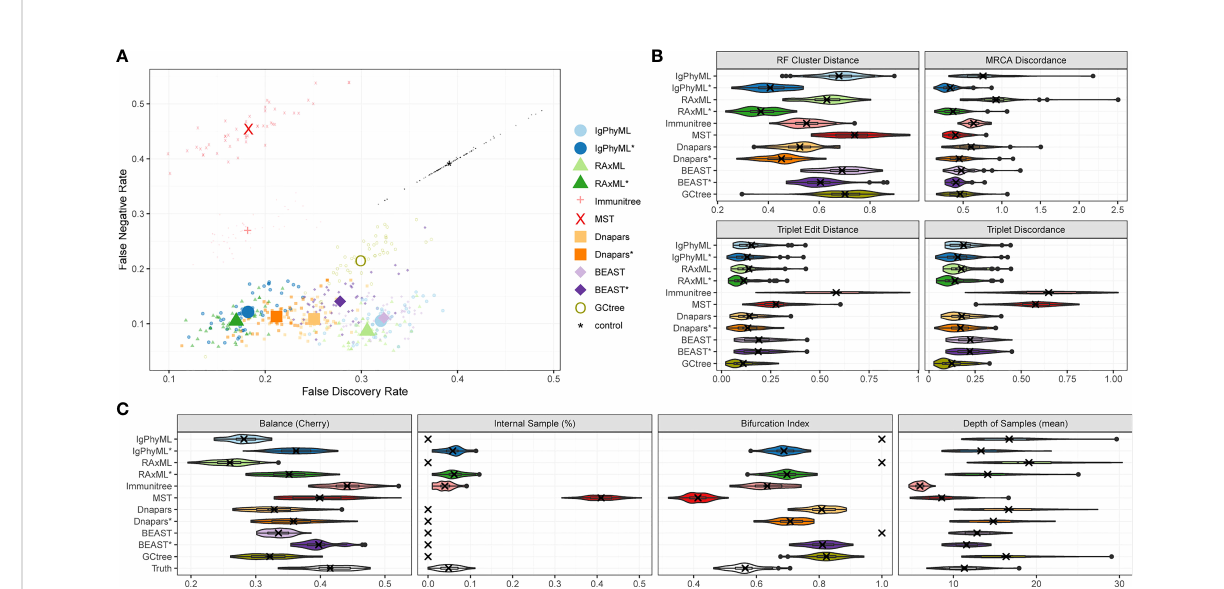
FIGURE 4 SARS-Cov2 simulations with default parameters. (A) False discovery rate (FDR) and false negative rate (FNR), (B) normalized Robinson-Foulds cluster distance (RF), MRCA discordance (MD), triplet edit distance (TED), and triplet discordance (TD) of various reconstruction methods all restricted to 48 replicates where all methods ran. The “ control ” trees are generated by randomly permuting labels of the true tree. Benchmarking results in (B) are normalized by the control trees. (C) Properties of the estimated and true trees. *: contracted